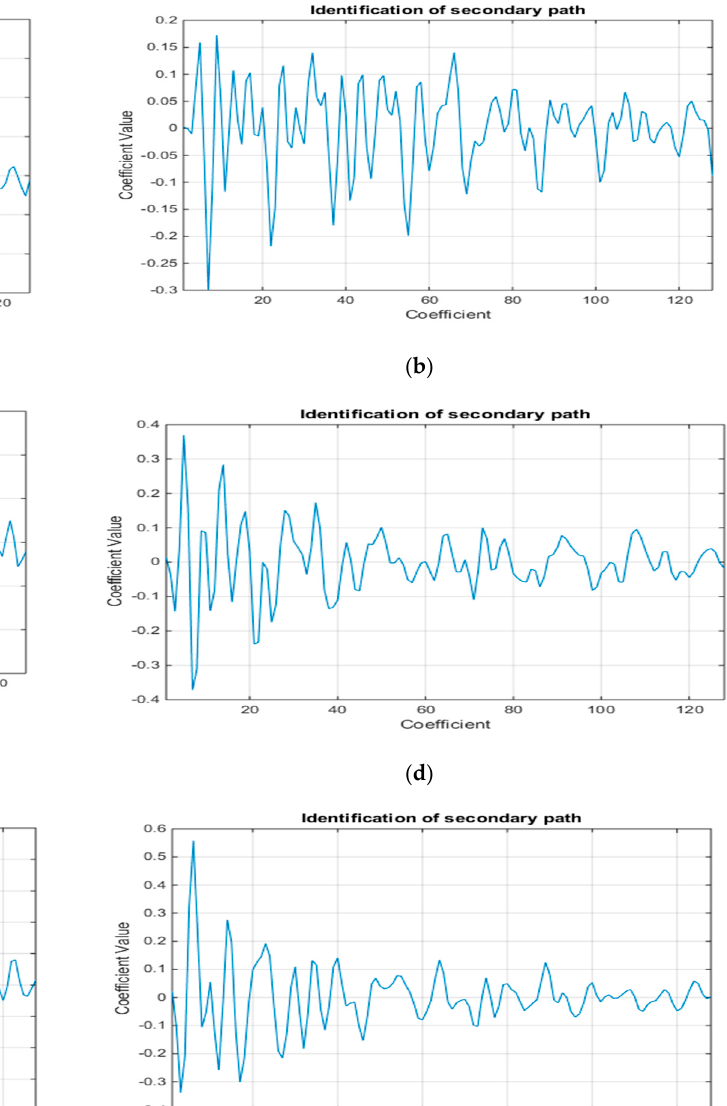
Figure 8. Identification process in primary paths. ( a ) Identification of  cation of 3 ( ) p P n ; ( d ) identification of